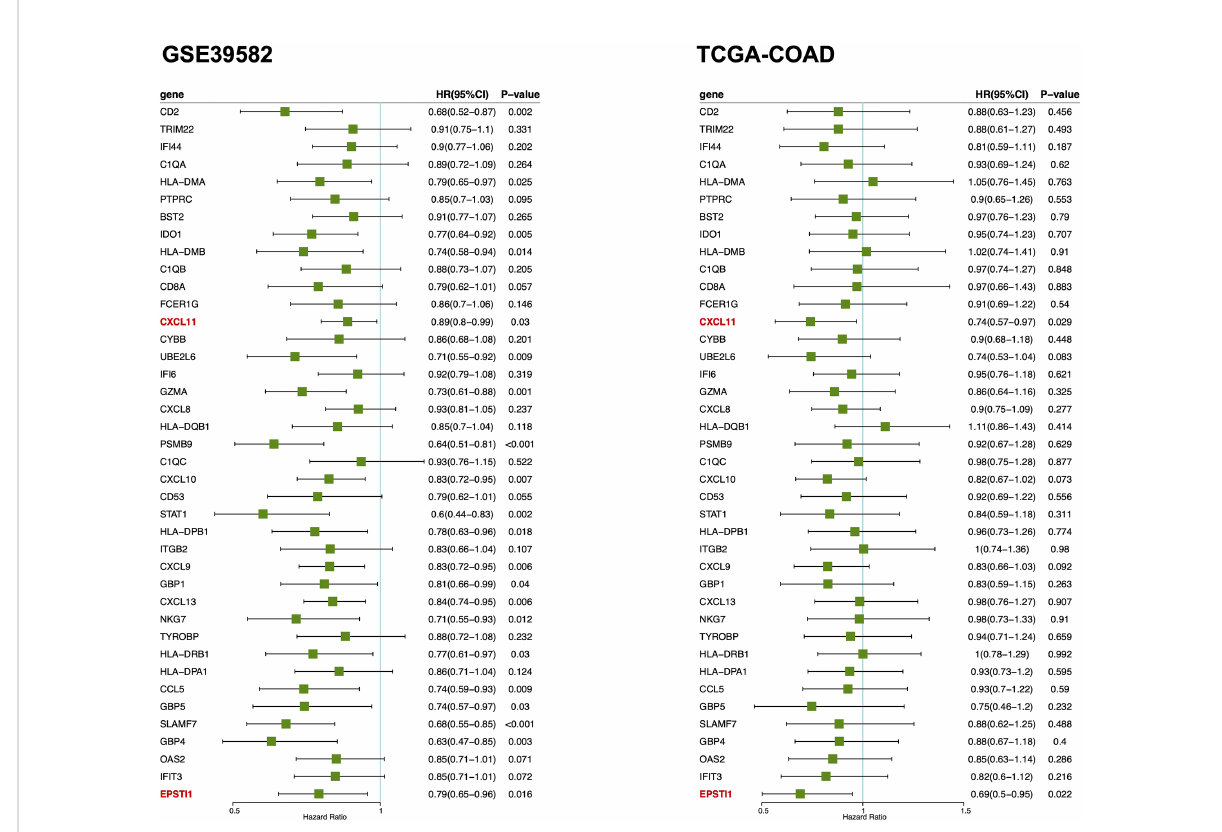
FIGURE 3 Forest plot of univariate Cox regression analysis for MCODE cluster 1 and 2. The results show that only the ESPTI1 and CXCL 11 are signi fi cant protective factors (HR < 1, P < 0.05) for RFS in both the GSE39582 and TCGA-COAD cohorts. MCODE, the Molecular Complex Detection algorithm; RFS, relapse-free